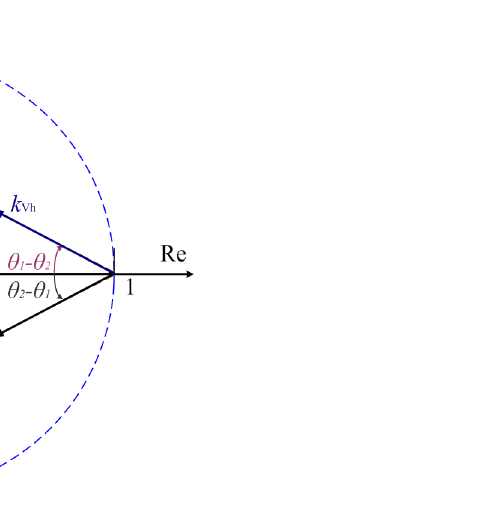
Fig 5. The poles of close-loop transfer